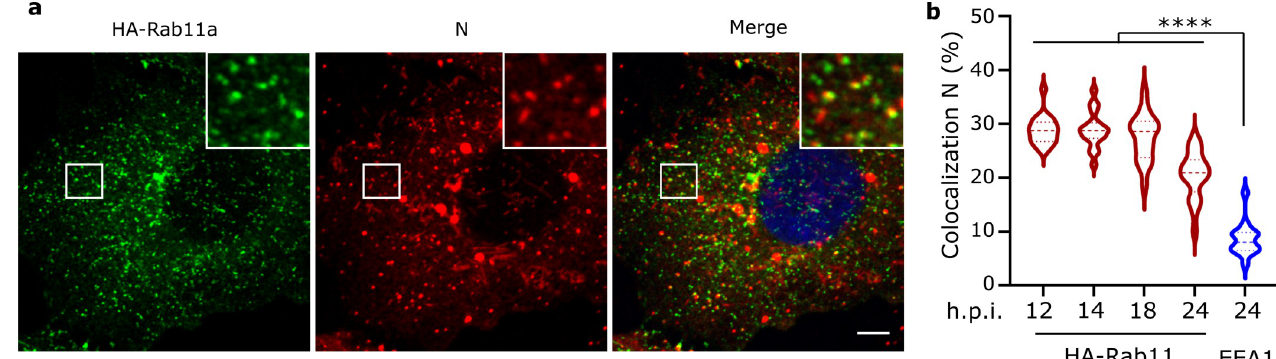
Fig 5. Colocalization of RNPs and Rab11a in RSV infected cells. a) A549-HA-Rab11a cells infected with RSV for 18 h. Rab11a (green) and RNPs (Red) were detected by immunostaining of HA and N. Images were visualized after gaussian filter fixed at 0.5. Scale bar 5 μ m. The boxed areas enclose Rab11a and N spots shown magnified. b) Percentage of N spots colocalizing with HA-Rab11a or EEA1 positive spots calculated using Icy Software. Violin plots show the median (center line) and the first and third quartiles (upper and lower hinges). Results are from 70 cells from 3 independent experiments. ���� p < 0.0001 using Brown- Forsythe and Welch’s ANOVA test followed by Dunn’s test for multiple